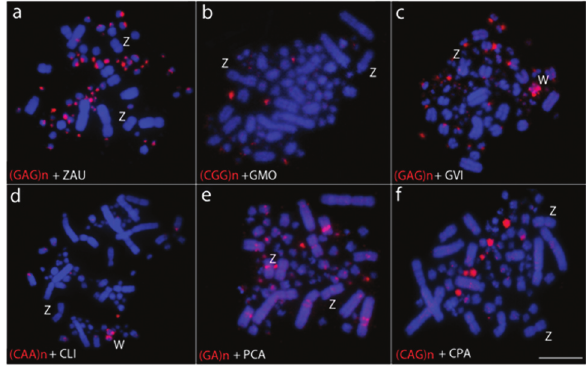
Figure 5 - Representative examples of FISH experiments using micro- satellite sequences in six Columbidae species (a-f). Probes were directly labeled with Cy3 (red), while chromosomes were counterstained with DAPI (blue). Microsatellite sequences are indicated on the bottom left of each figure. Sex chromosomes are indicated in each metaphase. ZAU: Zenaida auriculata (a); GMO: Geotrygon montana (b); GVI: Geotrygon violacea (c); CLI: Columba livia (d); PCA: Patagioenas cayennensis (e); CPA: Columbina passerina (f). Sex chromosomes are indicated in each metaphase. Bar = 5 (cid:2) m.